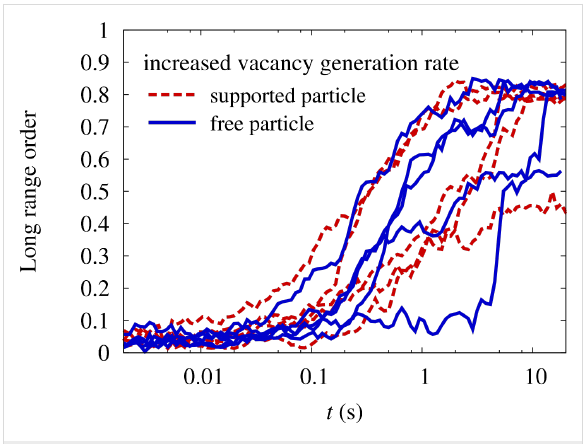
Figure 6: Evolution of LRO parameter with annealing time at 1000 K in free and supported FePt nanoparticles with only Pt-substrate interac- tions. In order to speed up the simulations, the vacancy generation rate has been increased by a factor ten compared to the thermal vacancy generation